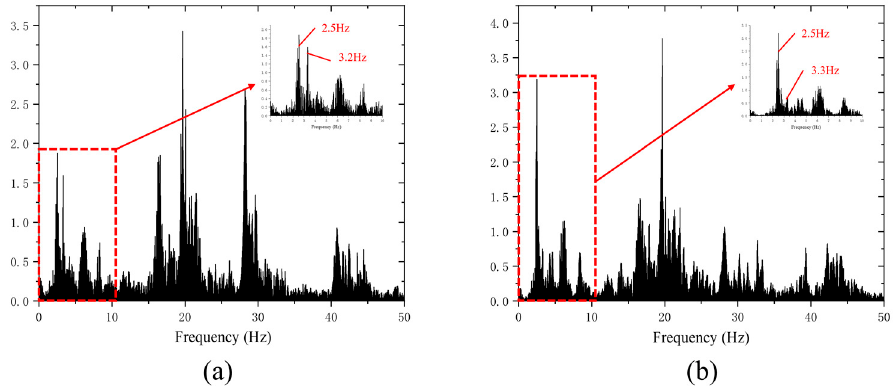
Figure 5. Nancun Yellow River Bridge natural vibration frequency test results: ( a ) accelerometer vibration test results; ( b ) vibration test results for smartphones.